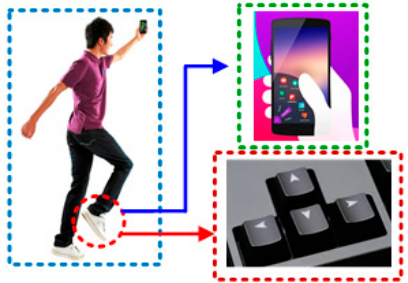
Figure 1. The main concept of proposed system.